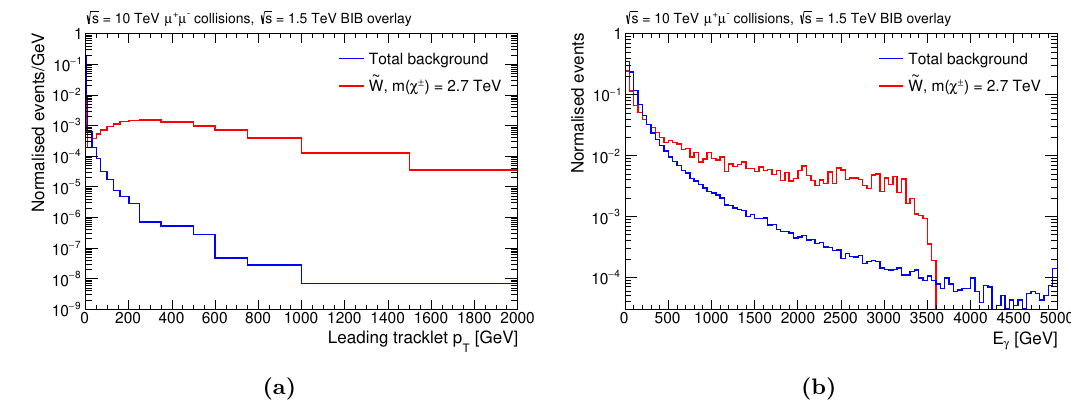
Figure 12. Distributions of the leading tracklet transverse momentum (a) and the leading photon √ energy (b) in s = 10 TeV muon collision events with at least a tracklet satisfying the requirements described in section 4.